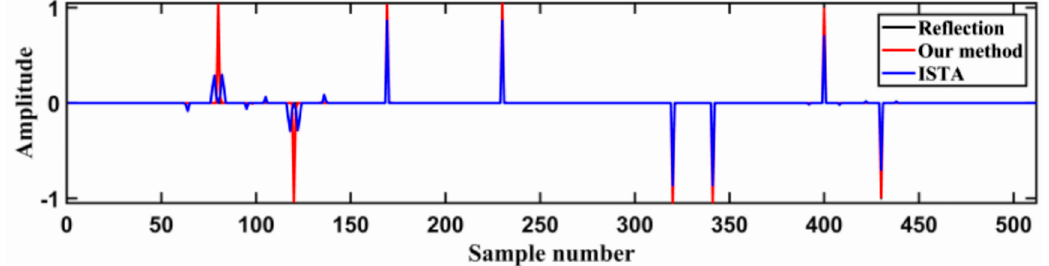
Figure 8. Comparison of the deconvolution results obtained by the algorithm proposed in this study (red spikes) and conventional ISTA (blue spikes).